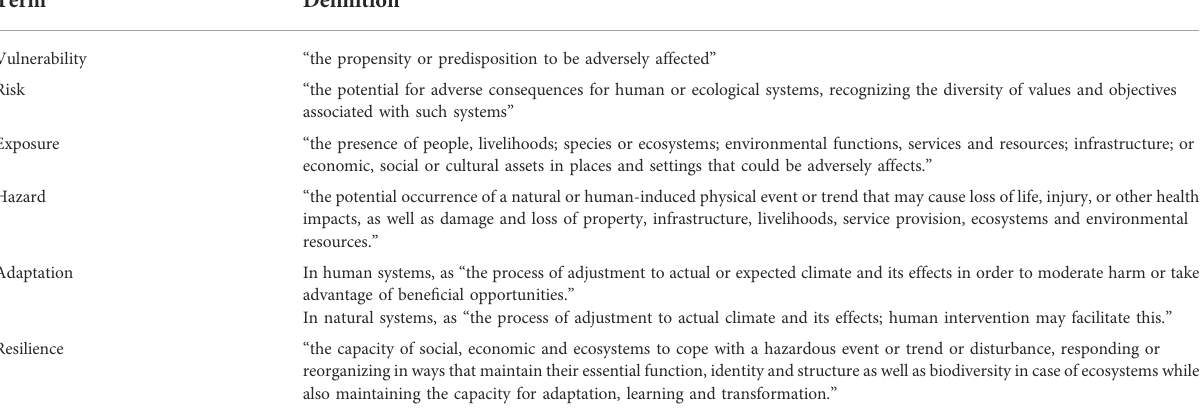
TABLE 1 Some de fi nitions of terms commonly used in extreme events literature as provided in the IPCC